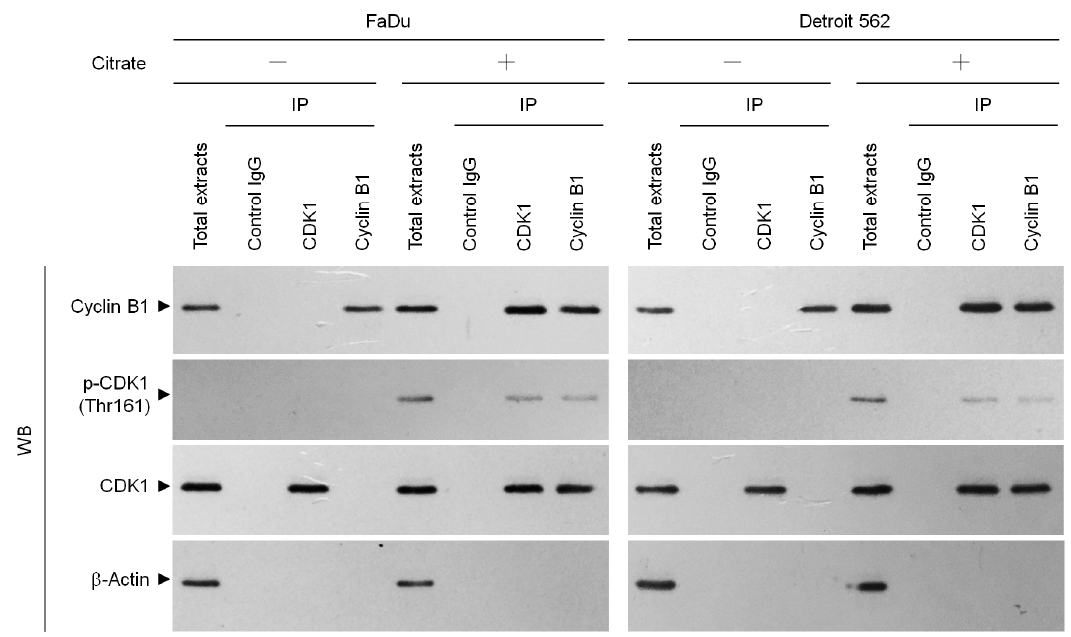
Figure 3. Induction of the formation of cyclin B1–phospho (p)-cyclin-dependent kinase 1 (CDK1) (Thr 161) complexes by citrate in human PSC cells. Cells were treated with vehicle ( − ) or citrate (10 mM) for 36 h. The antibody used for coimmunoprecipitation is indicated at the top. The proteins from the immunoprecipitated complexes were detected using Western blotting with specific antibodies. Normal immunoglobulin G (IgG) was used as a control for antibody